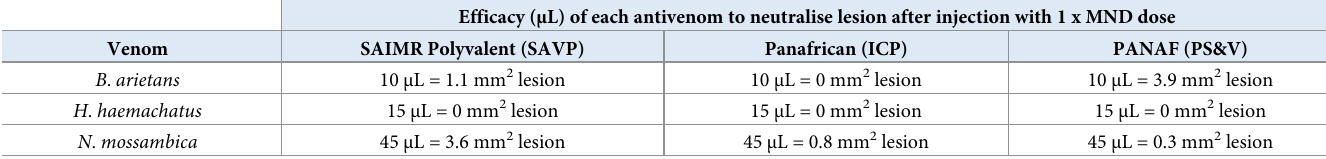
Table 4. The resulting in mean lesion size after intradermal injection with one MND dose of venom preincubated with each of the antivenoms. The dose of SAIMR Polyvalent in μ L was first determined, and the test antivenoms at this fixed volume were then tested to compare lesion